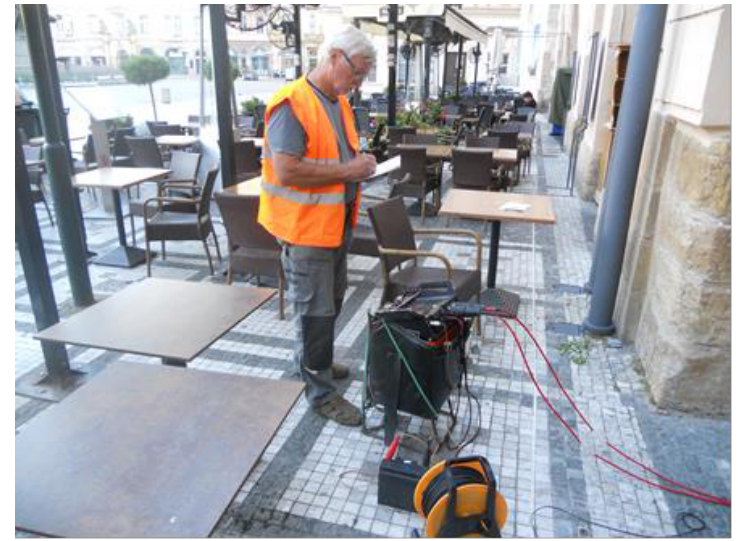
Figure 15. Seismic instrument Terraloc Mk-6 at the Old Town Square.